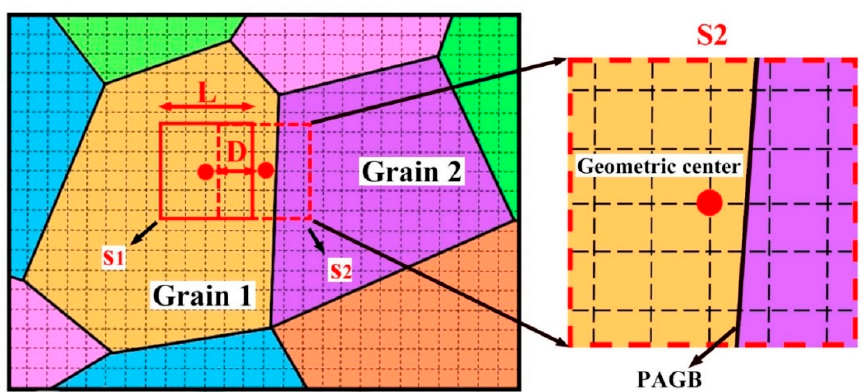
Figure 1. Schematic representation of a scanned orientation map and cropped data squares.